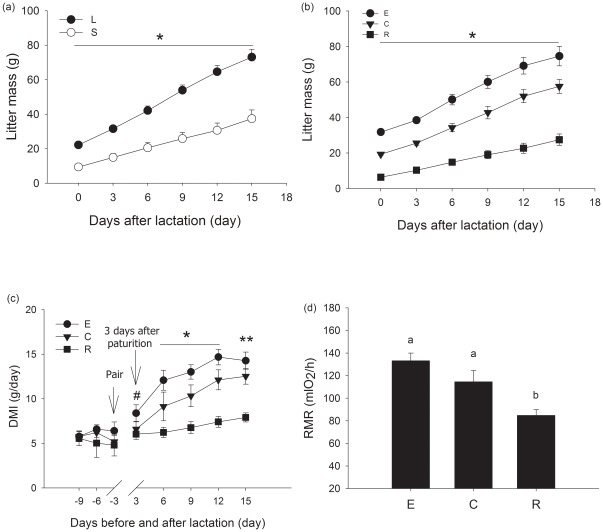
Changes of litter mass (a) during lactation.L represents large litter size group, and S represents small litter size group. Changes of litter mass (b) after manipulation during lactation. E represents enlarged litter size group, C represents non-manipulated litter size group, and R represents reduced litter size group. Changes of dry matter intake (DMI) (c) over time and RMR (d) on day 13 of lactation. Values are means ± s.e.m. Significant differences in litter mass between L and S group or litter mass and food intake between E, C and R are indicated by an asterisk if P<0.05. A pound sign indicates significant differences in DMI between E and R group, and a double asterisk indicates significant differences between E and R group, and between C and R group if P<0.05, whereas significant differences in RMR between E, C and R are indicated by different letters if P<0.05.